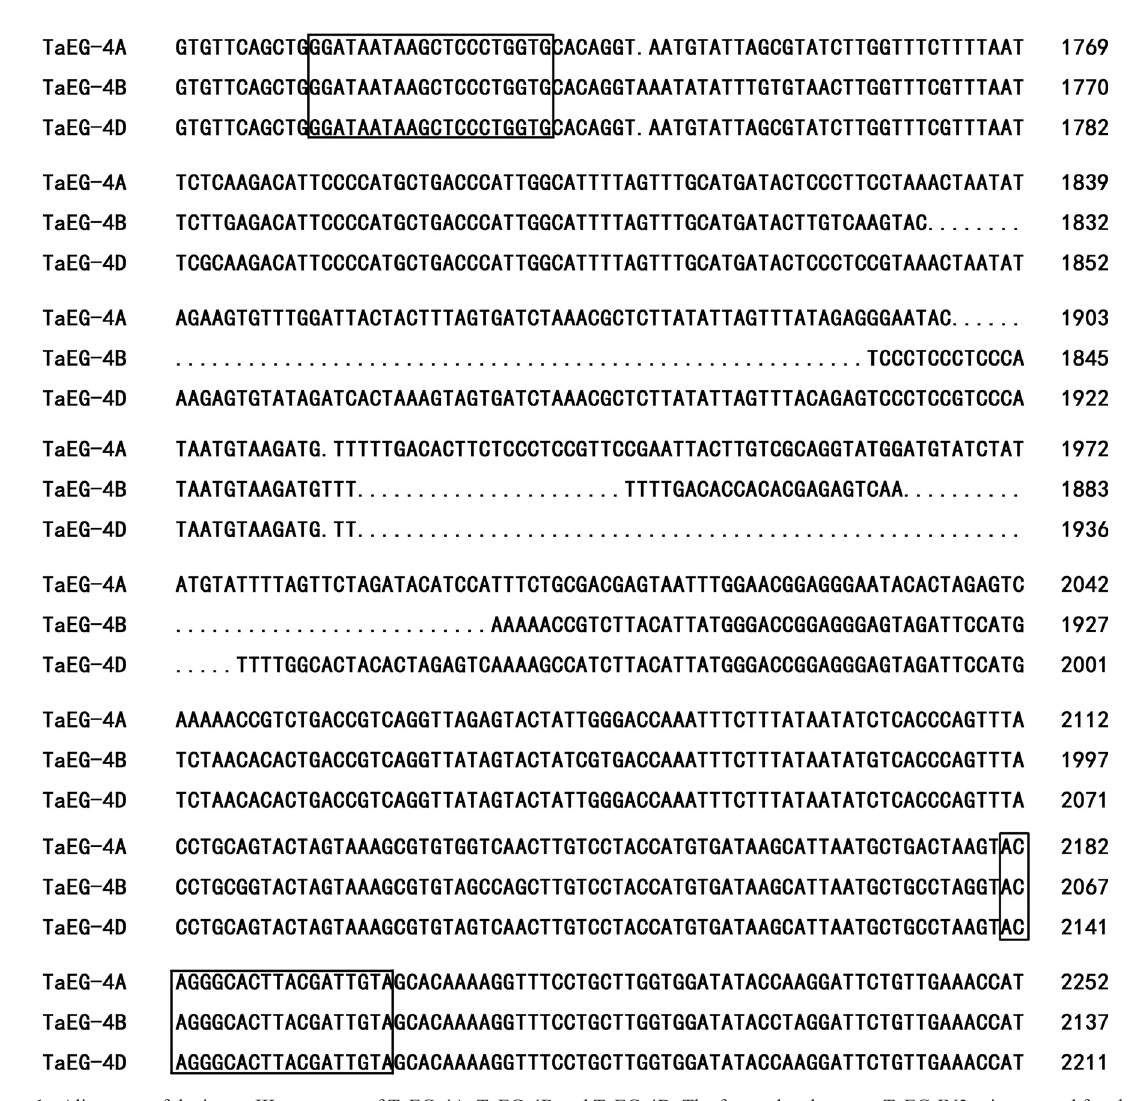
Figure 1 - Alignment of the intron III sequences of TaEG-4A, TaEG-4B and TaEG-4D. The forward and reverse TaEG-IN3 primers used for chromo- some location are